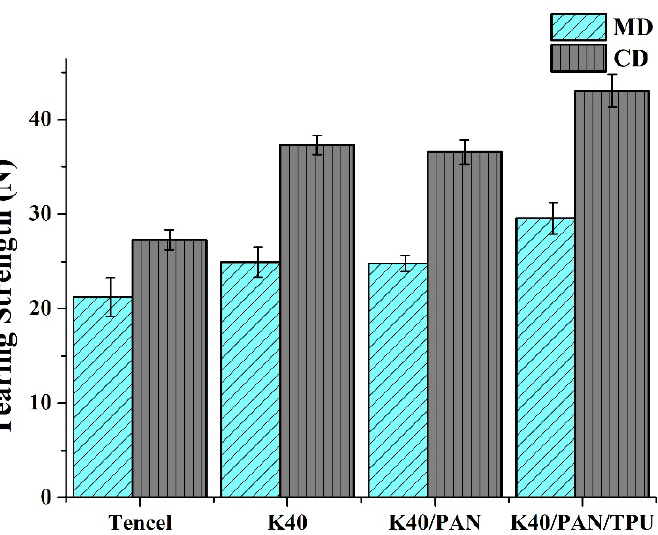
Figure 3. Tearing strength along the MD and CD of Tencel, K40, and K40/PAN/TPU lay-up com- pound matrices.